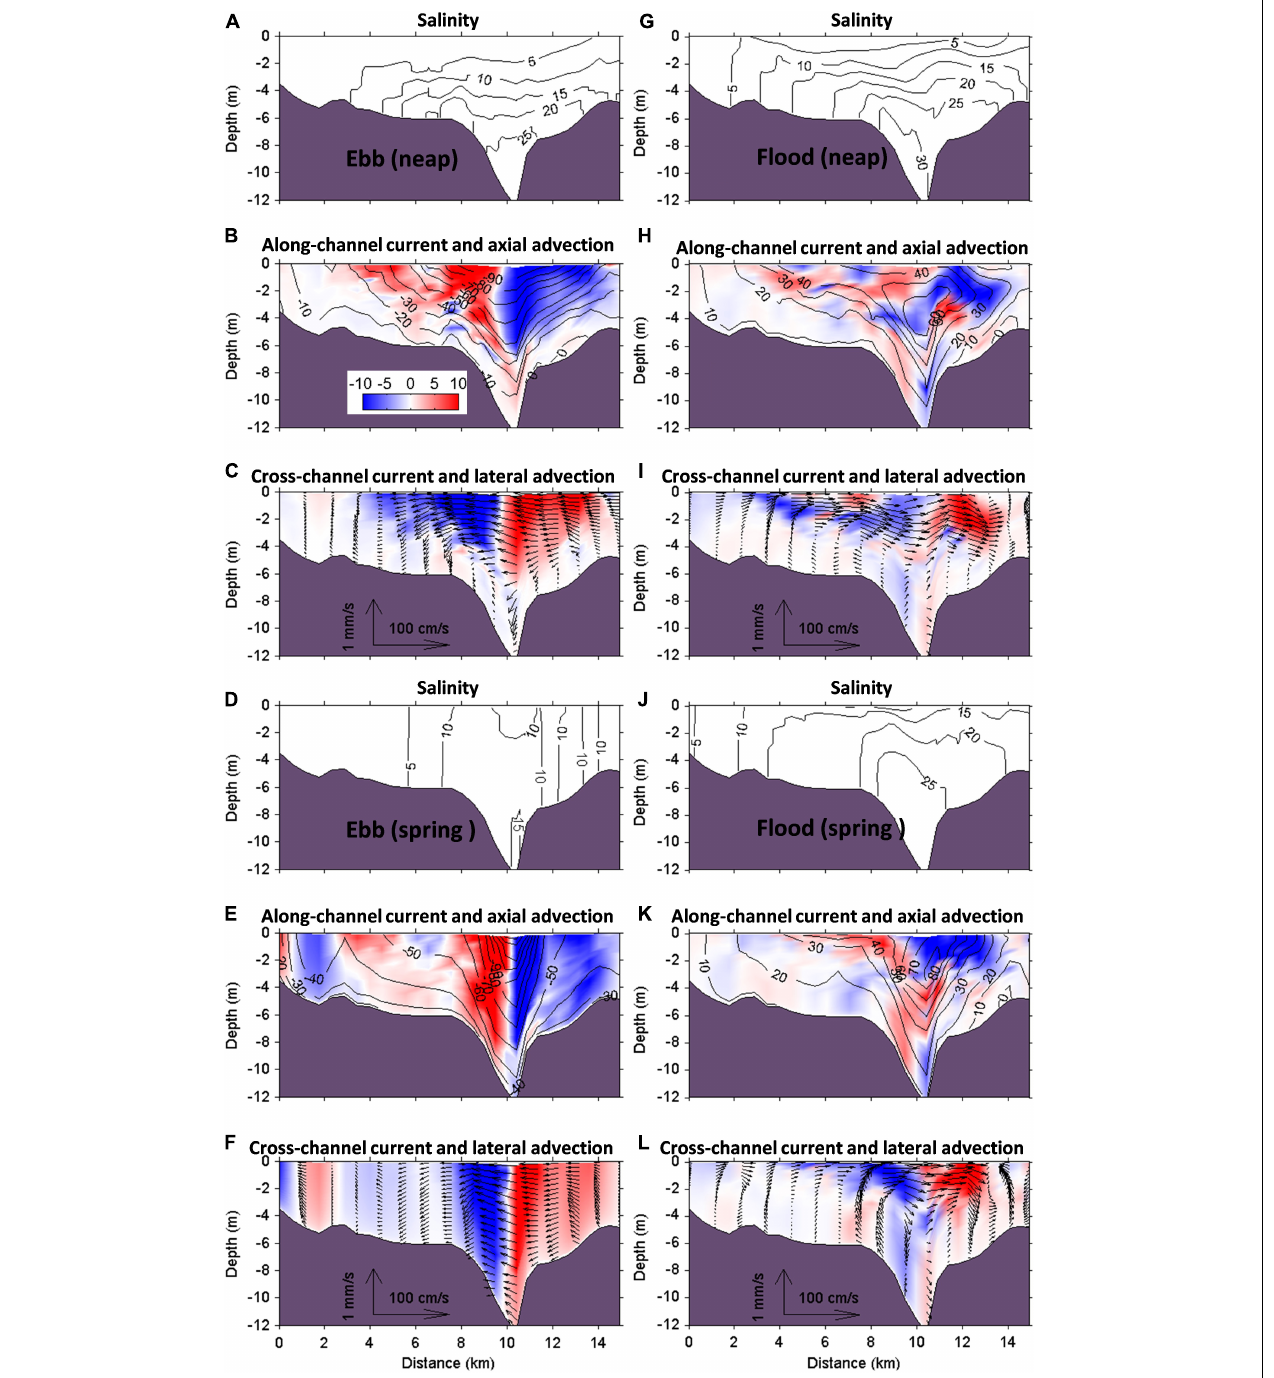
FIGURE 8 | Instantaneous salinity, along-channel current velocity (contour line) with axial advection (color shape), and cross-channel current velocity (contour line) with lateral advection (color shape) at maximal ebb during neap tide (A–C) , maximal ebb during spring tide (D–F) , maximal flood during neap tide (G–I) , and maximal flood during spring (J–L) along the cross-channel section S. The positive along-channel current directs toward land, and positive cross-channel current directs from the west toward the east shoals as one looks into the